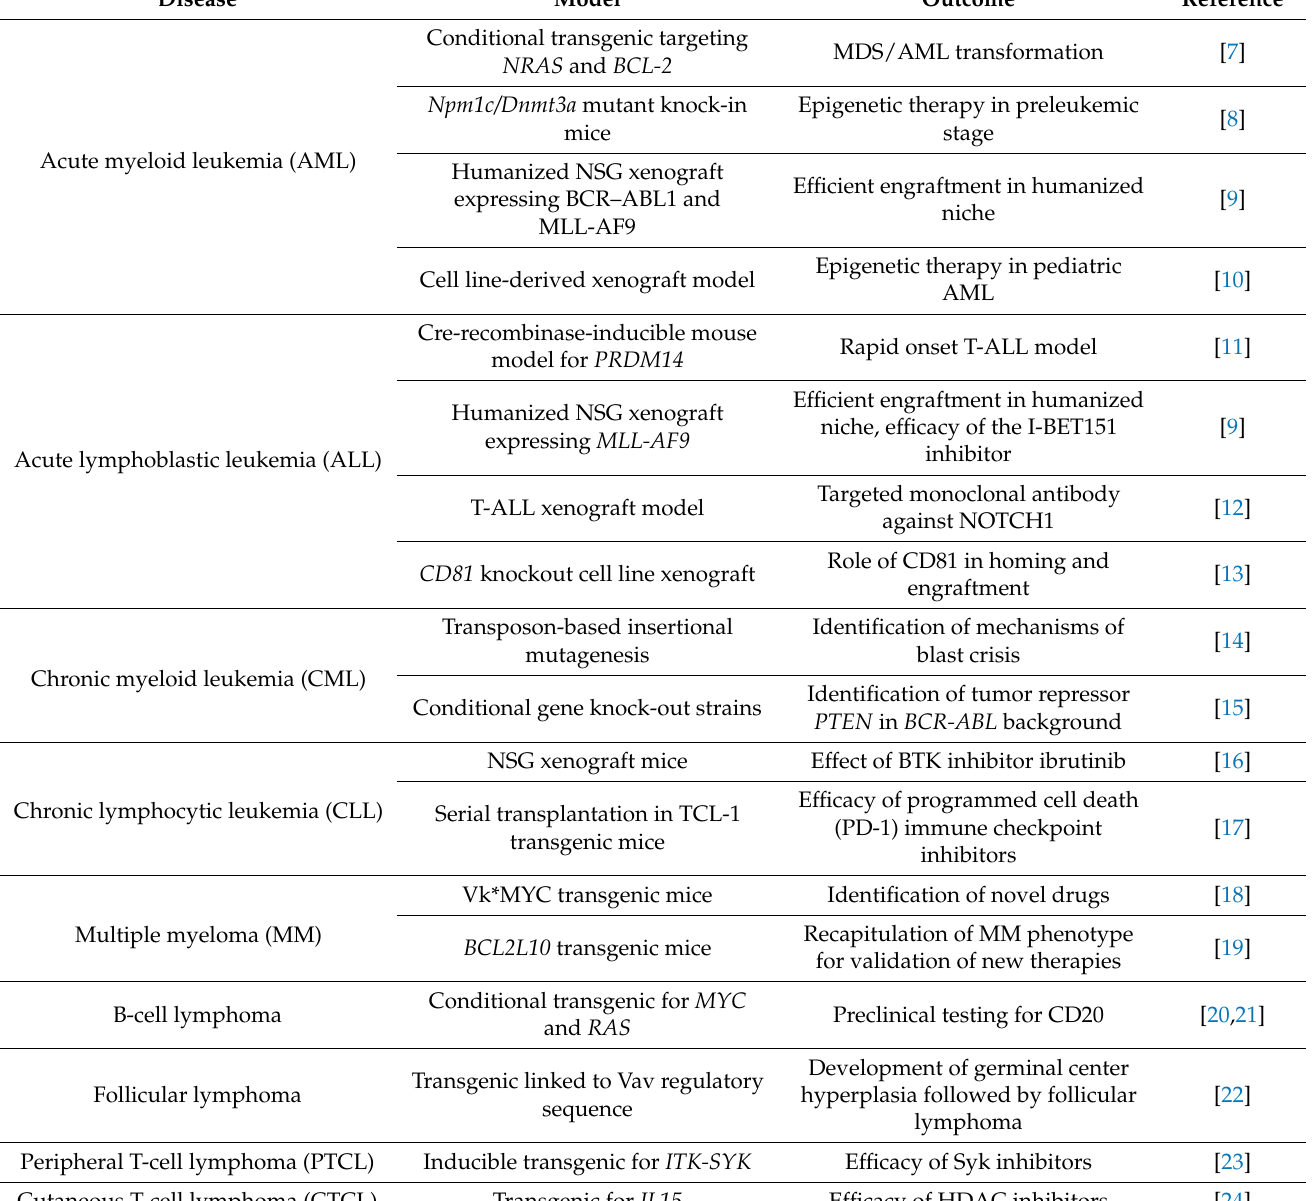
Table 1. Examples of murine models for hematological